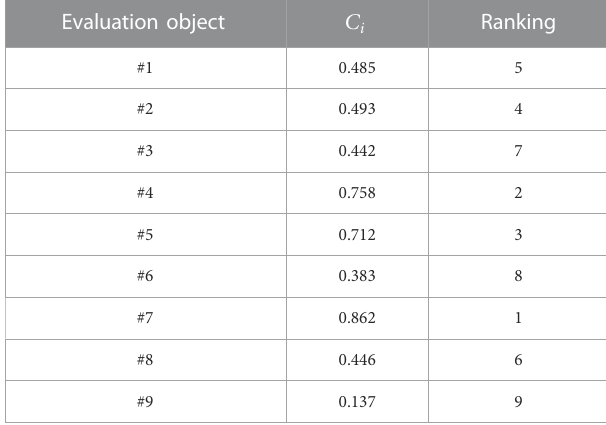
TABLE 5 Evaluation results. Evaluation object